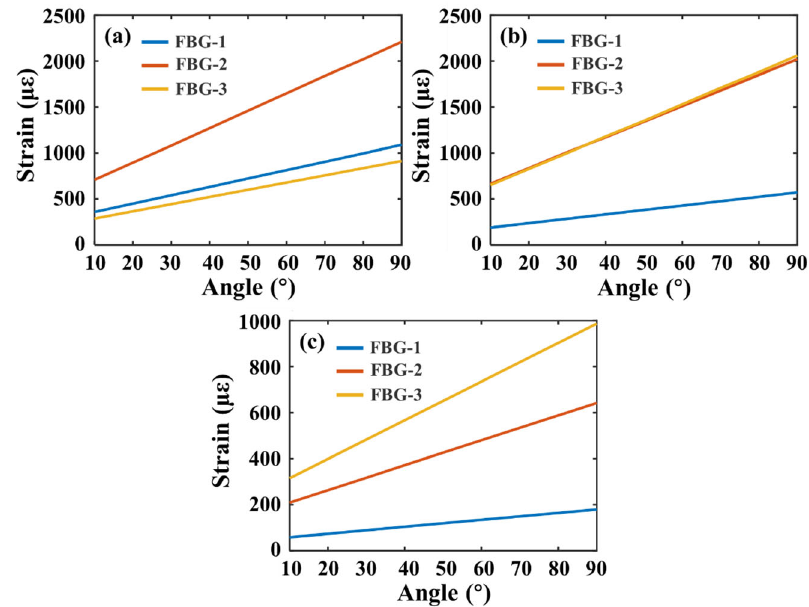
Figure 6. Strain varies with bending angle. ( a ) Strain analysis during knuckle ‐ 1 bending; ( b ) Strain analysis during knuckle ‐ 2 bending; and ( c ) Strain analysis during knuckle ‐ 3 bending.